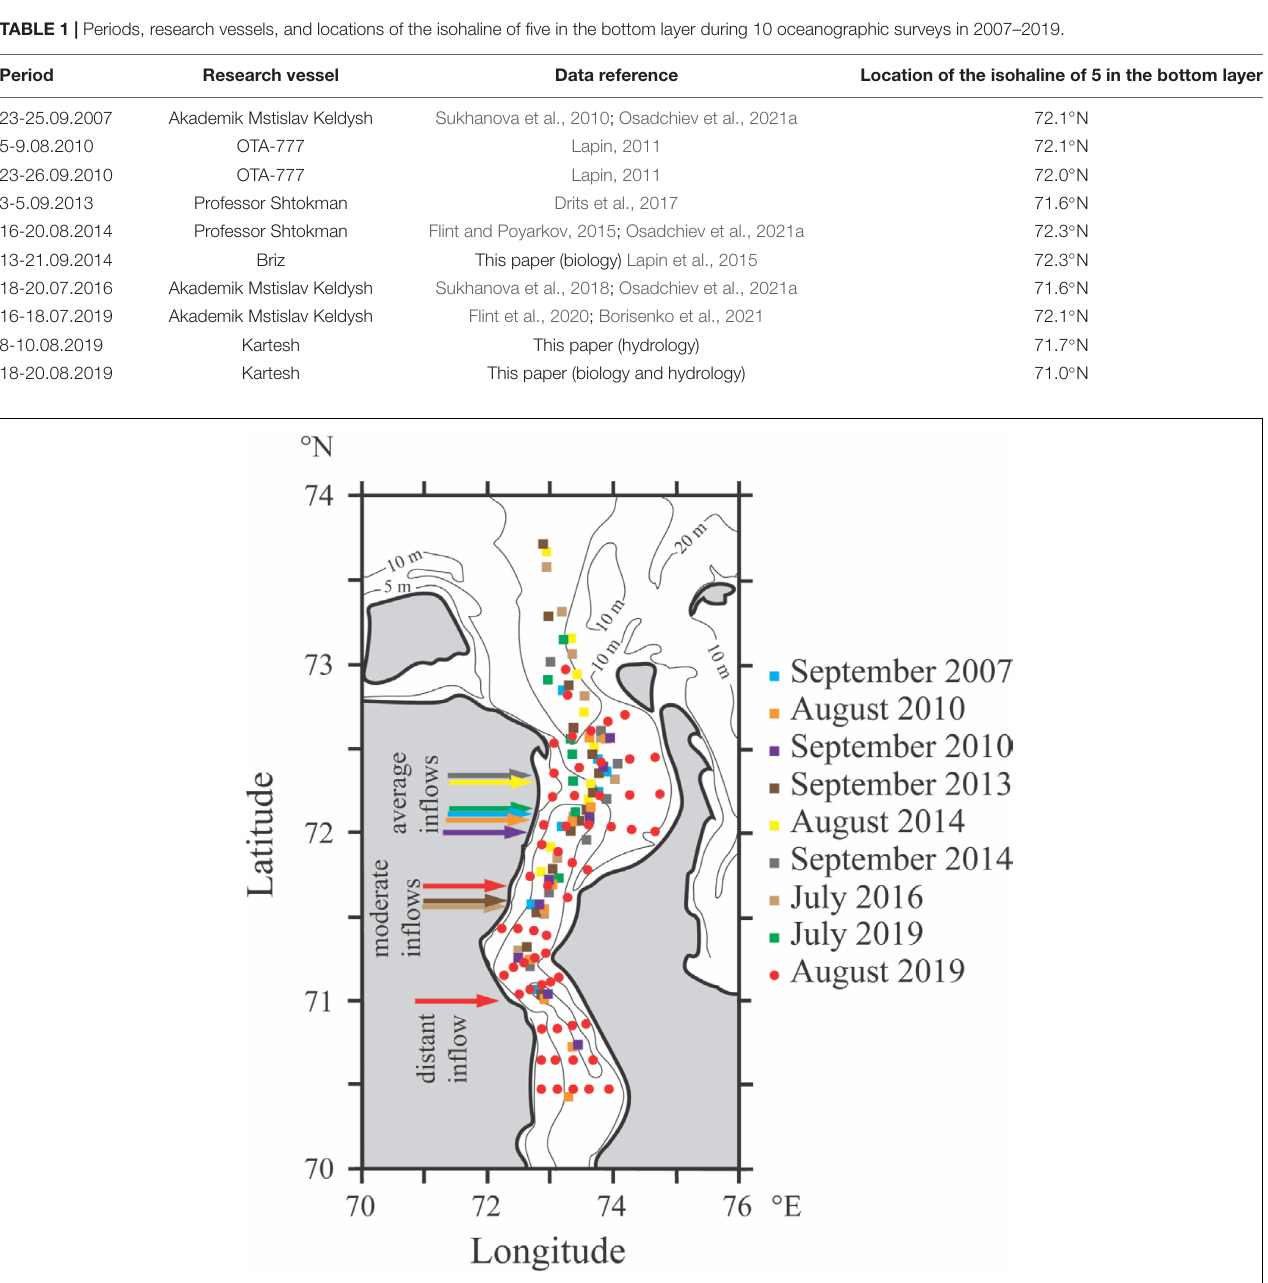
FIGURE 2 | Hydrographic stations of 10 oceanographic field surveys conducted in the Gulf of Ob in 2007–2019 (circles for the two surveys in August 2019, squares for all other cruises). Arrows indicate southernmost detected locations of the isohaline of five in the bottom layer of the Gulf of Ob. Note that the two surveys in August 2019 are indicated by two red